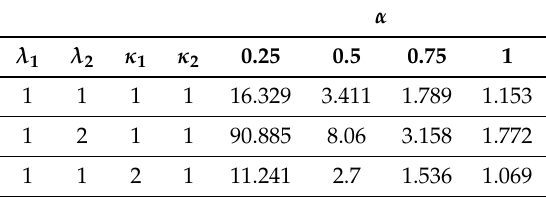
Table 3. Value of variable τ fulfilling equation S ( τ ) = 1 obtained from numerical solution.